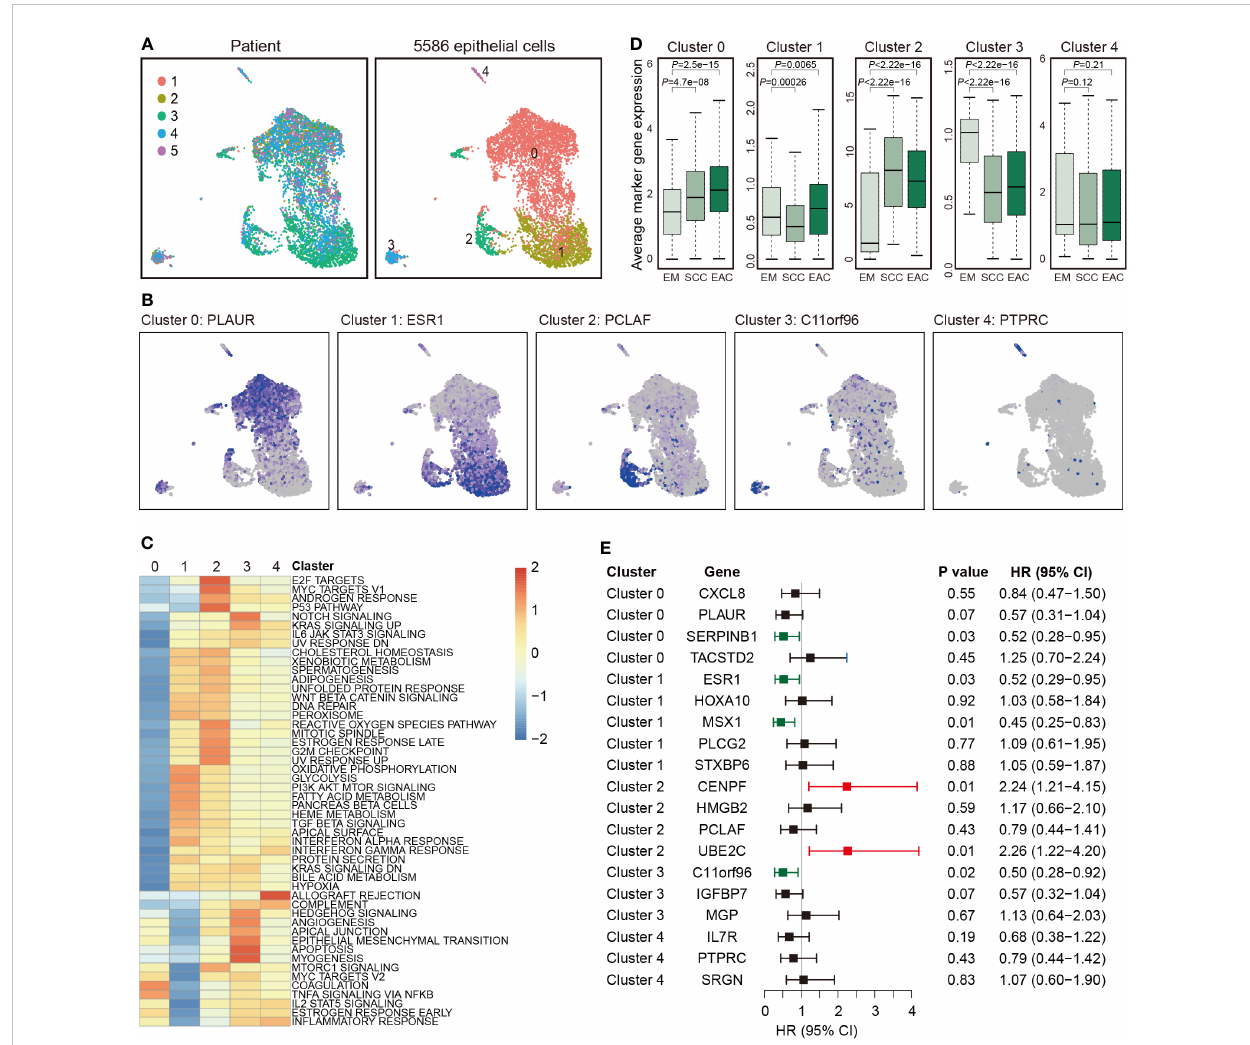
FIGURE 3 Epithelial cell clusters. (A) Uniform manifold approximation and projection (UMAP) plot of 5,586 epithelial cells, color-coded by their corresponding patient (left) or associated cluster (right). (B) Expression of represent marker genes for each cluster. (C) Differences in pathway activities scored per cell by GSVA between the different clusters. Shown are t values from a linear model. (D) Average expression of the marker genes for endothelial cells from each cluster in TCGA samples from endometrium (EM, n = 35), serous cystadenocarcinoma (SCC, n = 133) or endometrioid adenocarcinoma (EAC, n = 401). (E) Forest plot showing HR (95% CI) of the marker genes in